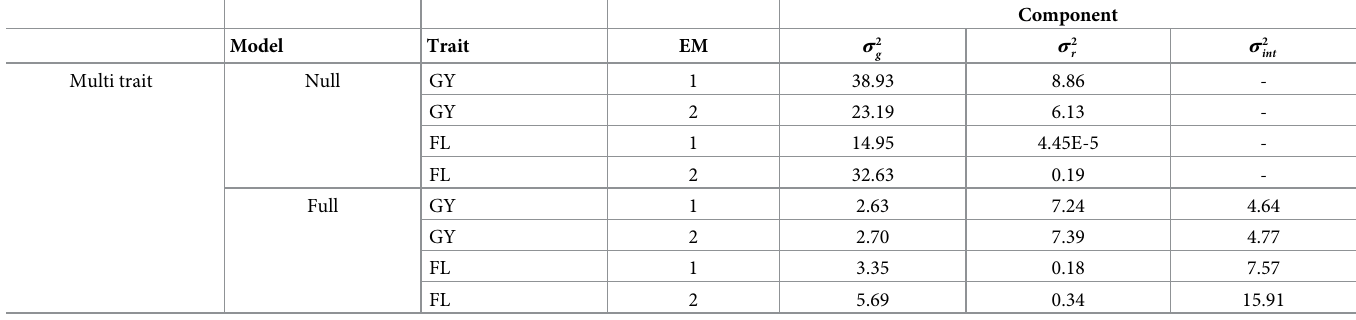
Table 4. Genetic parameters for traits grain yield and flowering period in days, in two environments, using multi-trait multi-environment (MTME) models.